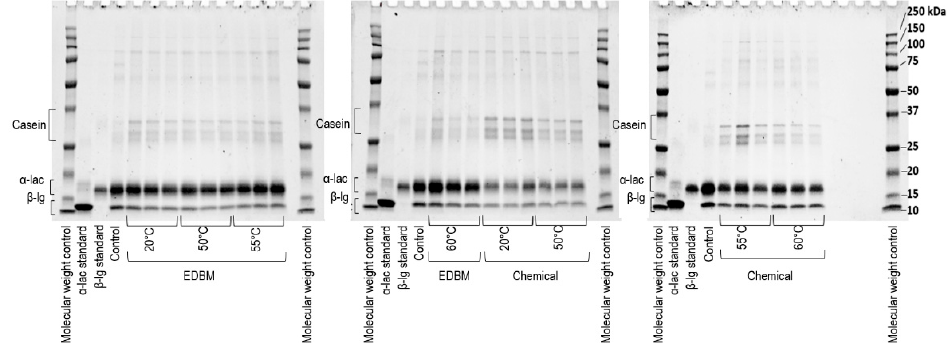
Figure 3. Denatured and reduced PAGE of precipitated fractions recovered after acidification at pH 4.8.